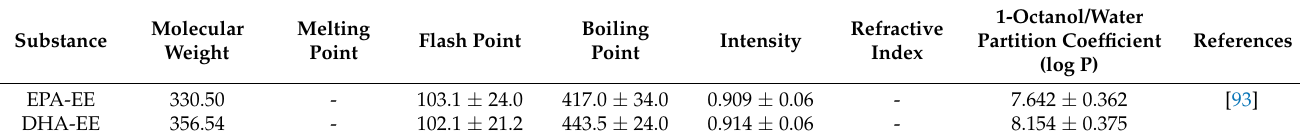
Table 4. Properties of EPA ‐ EE and DHA ‐ EE.